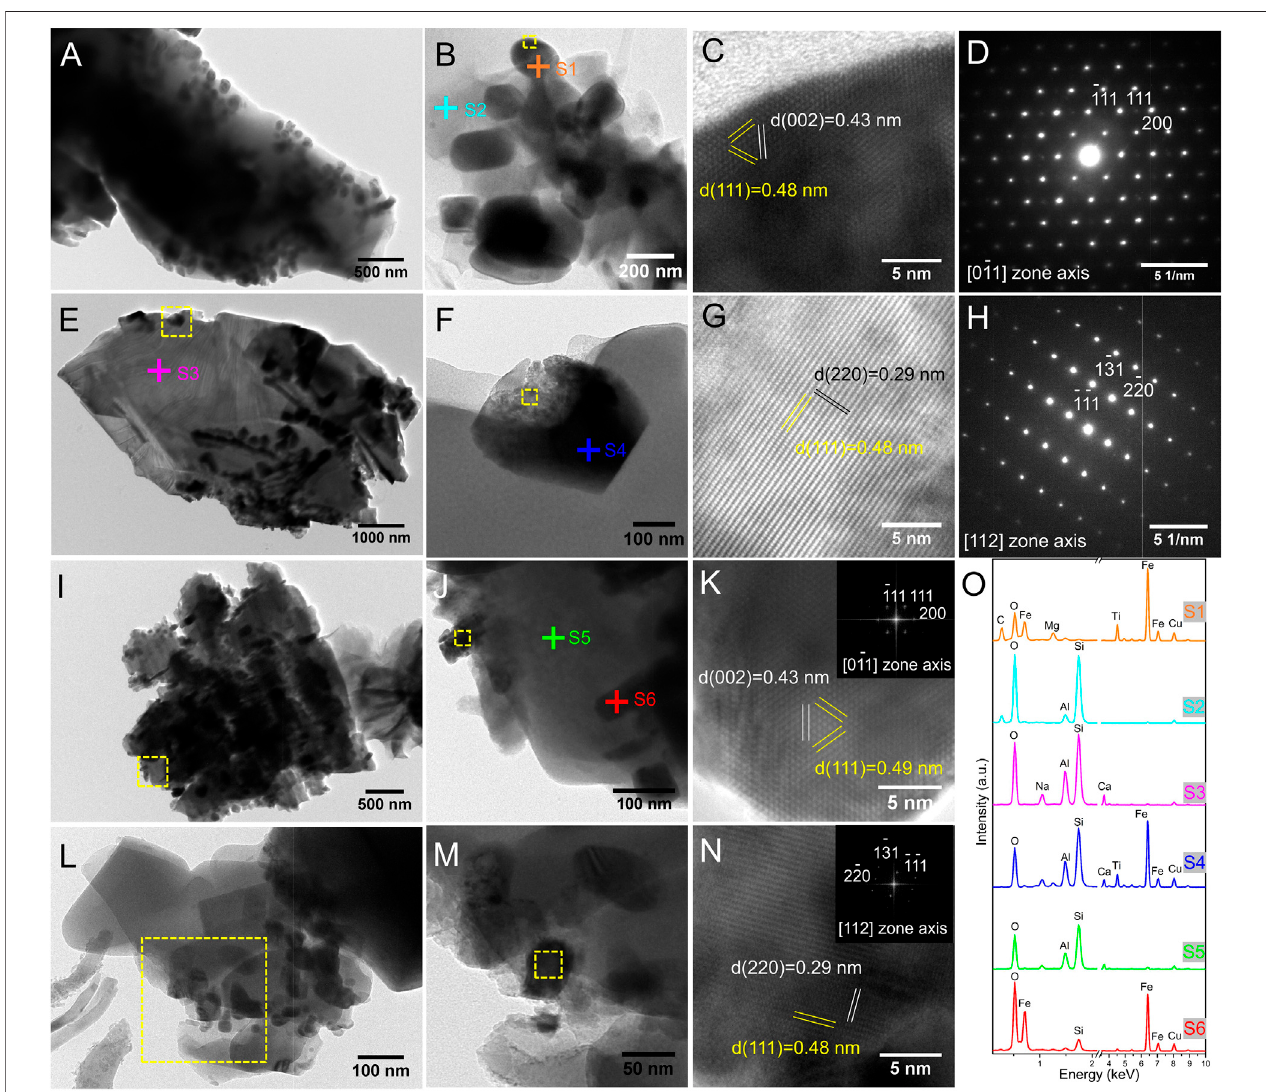
FIGURE 6 | TEM analyses of Type-4 magnetite inclusions hosted within silicates. (A) TEM image of a silicate particle hosting many dispersed titanomagnetite or magnetiteinclusions. (B – D) Titanomagnetite ormagnetiteparticles likelyattached tosilicates: (B) low-magni fi cationTEMimage, (C) HRTEM imageofpartoftheparticle in the yellow dashed box in (B) and (D) the corresponding SAED pattern recorded from the [011] zone axis. (E – H) Silicate particle hosting many titanomagnetite or magnetite inclusions: (E) low-magni fi cation TEM image, (F) TEM image of a single particle indicated by the yellow dashed box in (E) , (G) HRTEM image of a small region of the particle in (F) and (H) SAED pattern recorded from the [112] zone axis of the particle in (F) . (I – K) TEM images of (I) a silicate particle hosting many titanomagnetiteormagnetiteinclusionsand (J) ofasmall regionindicatedbytheyellowdashed boxin (I) , (K) HRTEM image(inset isthecorrespondingFFTpattern)ofa particle indicated by the yellow dashed box in (J) . (L – N) TEM images of (L) several titanomagnetite or magnetite inclusions that are likely embedded in, and attached to, silicates, and (M) a small region indicated by the yellow dashed box in (L) , and (N) HRTEM image (inset is the corresponding FFT pattern) of a particle indicated by the yellow dashed box in (M) . (O) EDXS spectra for different particles or regions of interest (indicated by colored crosses and names in (B) , (E) , (F) and (J) ). The d -spacing values from HRTEM observations and indirectly calculated from SAED analyses, combined with corresponding TEM-EDXS point analyses, SAED and FFT patterns, match the crystal structure ( Fd 3 m space group) of magnetite or